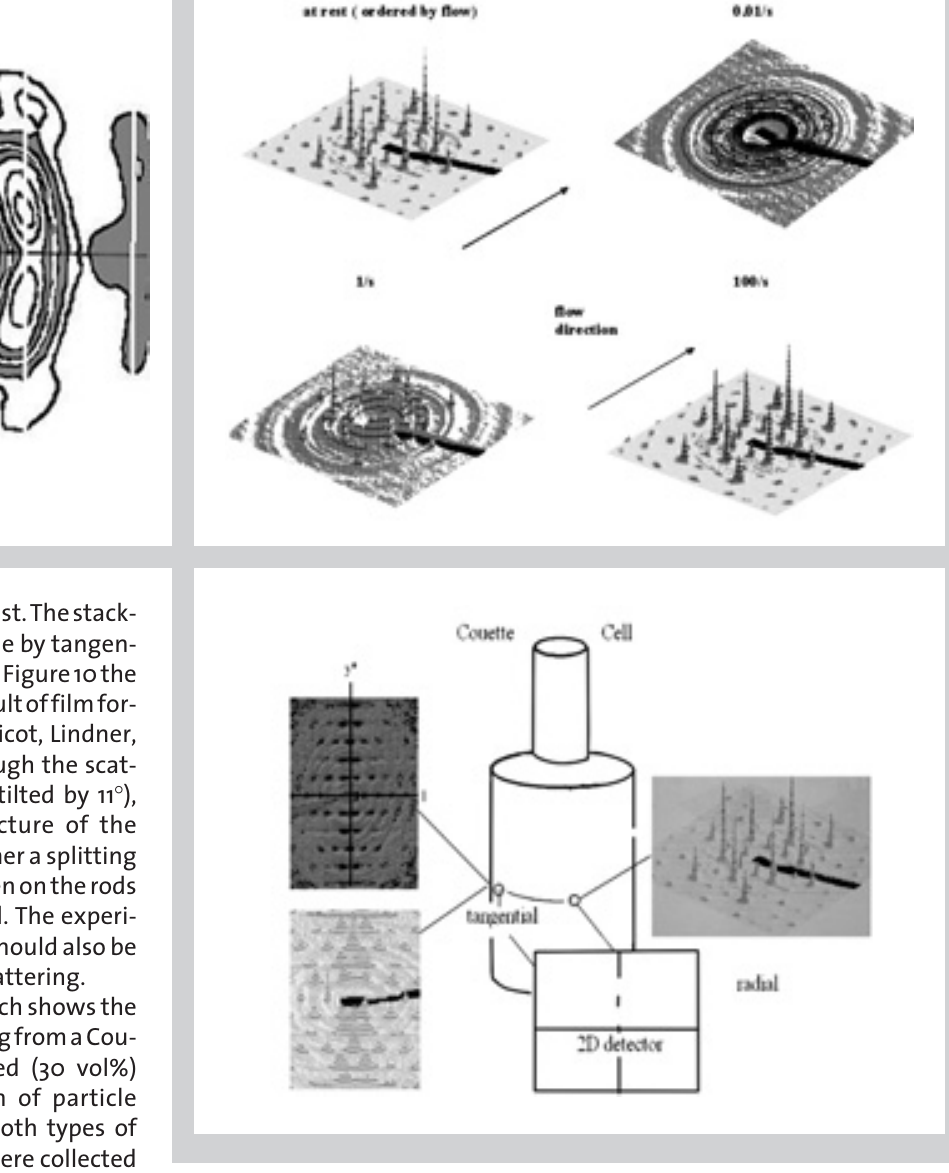
Figure 9 (right above): Synchrotron x-ray scatter- ing (SAXS) of the viscoelastic transition. Figure 10 (left above): Neutron scattering from a latex film (Redrawn after [20]). Figure 11 (below): Synchrotron x-ray scatter- ing (SAXS) on the anisotropy of a concentrated disper-